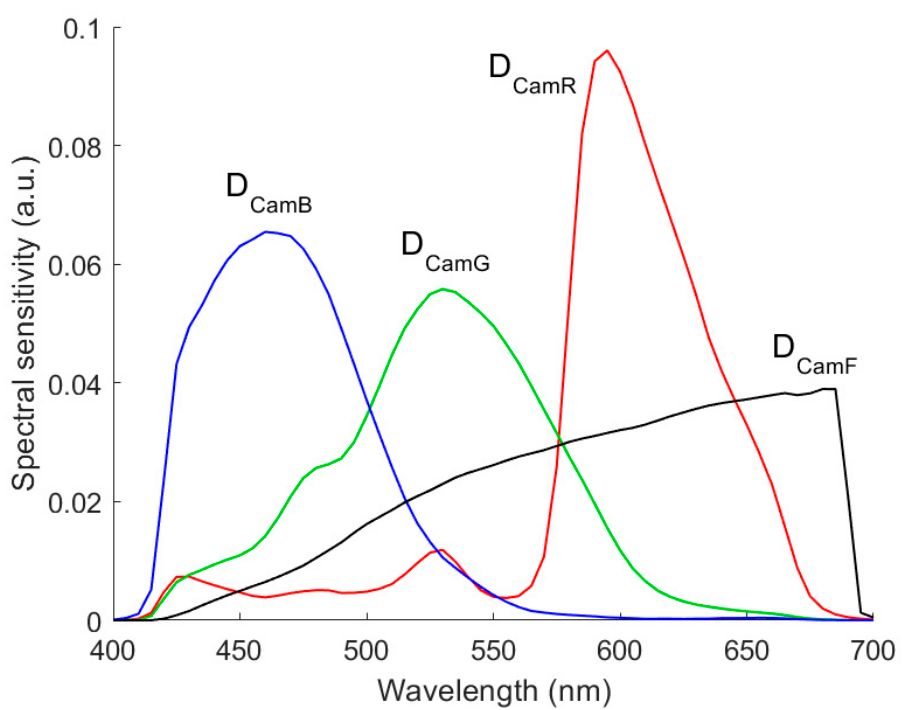
Figure 2. The spectral sensitivities of red ( D CamR ), green ( D CamG ), blue ( D CamB ), and F ( D CamF ) channels of the RGBF camera under the white balance condition.